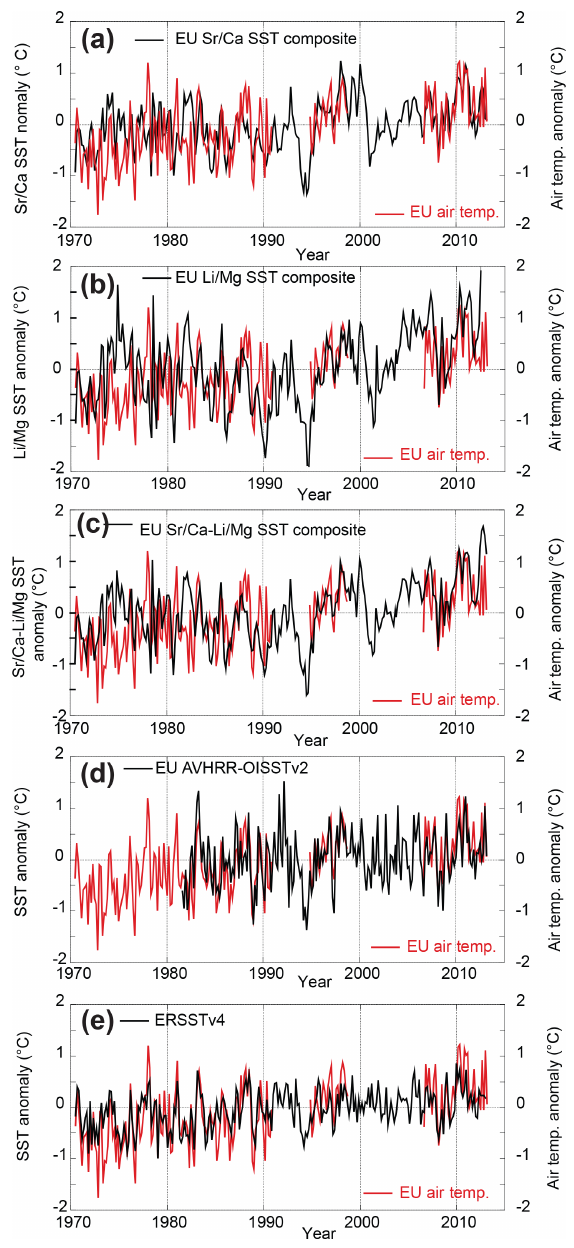
Figure 8. Comparison of coral composite Sr / Ca SST, Li / Mg SST, and Sr / Ca–Li / Mg SST anomaly reconstructions with air tempera- ture from Europa Météo-France weather station data. (a) Sr / Ca SST composite, (b) Li / Mg SST composite, (c) Sr / Ca–Li / Mg SST com- posite, (d) Europa gridded AVHRR-OISSTv2 (Banzon et al., 2016), and (e) Europa gridded ERSSTv4. Anomalies were calculated rela- tive to the 1981 to 2010 average bimonthly seasonal cycle for proxy reconstructions, instrumental SST, and air